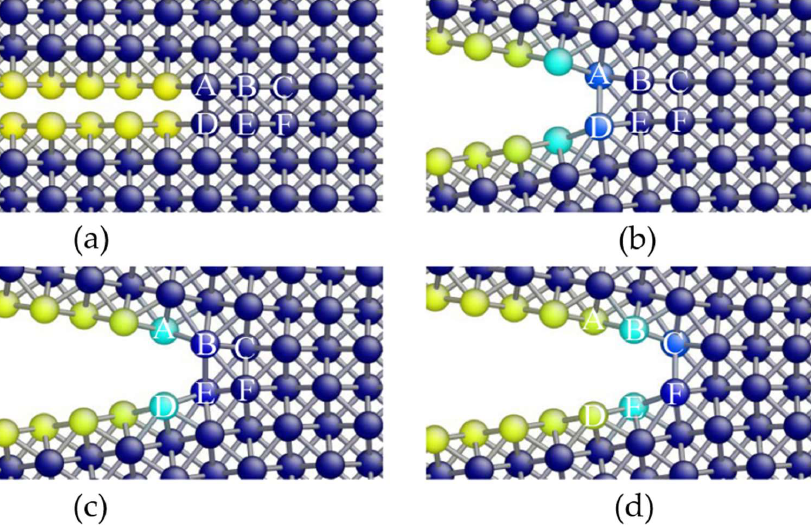
Figure 6. Snapshots of the atomistic configuration corresponding to different stages of the Ni nanoplate with a crack length of 25 c . Atoms are colored according to the  22 component of the atomic stress, with blue indicatinglow stress and red representing high stress. ( a ) Initial relaxed state before applying tensile displacement. ( b ) The linear stage. ( c ) Immediately before the crack propagation. ( d ) The declining stage.